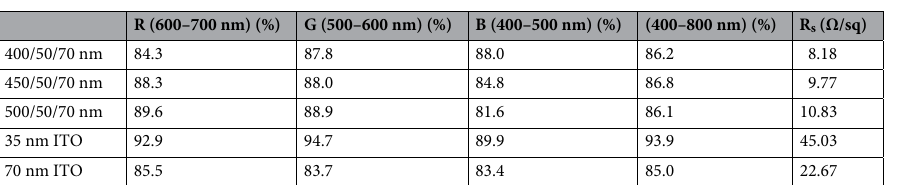
Table 3. Measured transmittance of the optimized TCEs within three different wavelength ranges and sheet resistance.